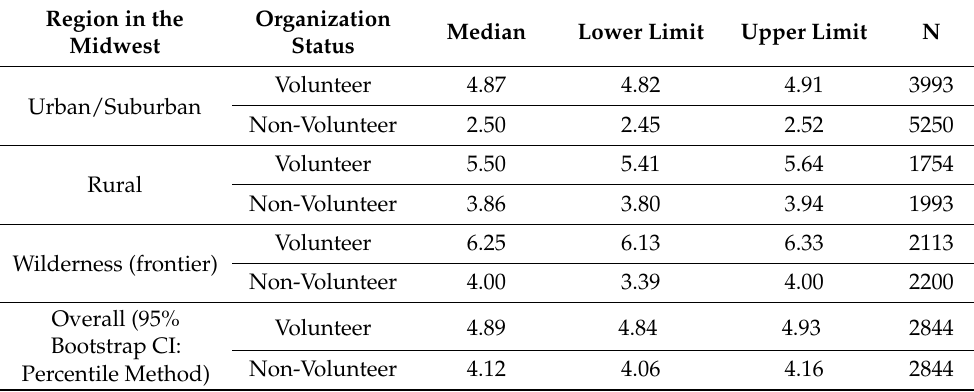
Table 1. Chute time in minutes in Midwest refer to NEMSIS (95% Confidence